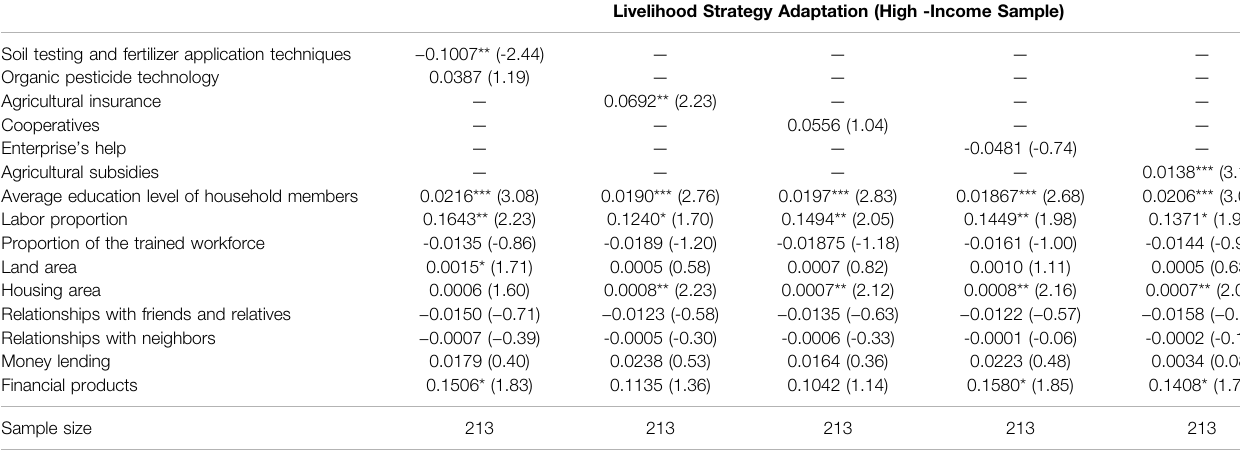
TABLE 7 | Regression results for the high-income